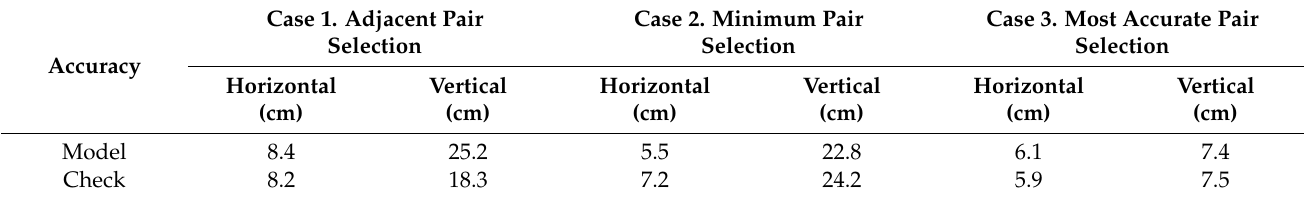
Table 5. Accuracy analysis results of DSMs and ortho-mosaic images.